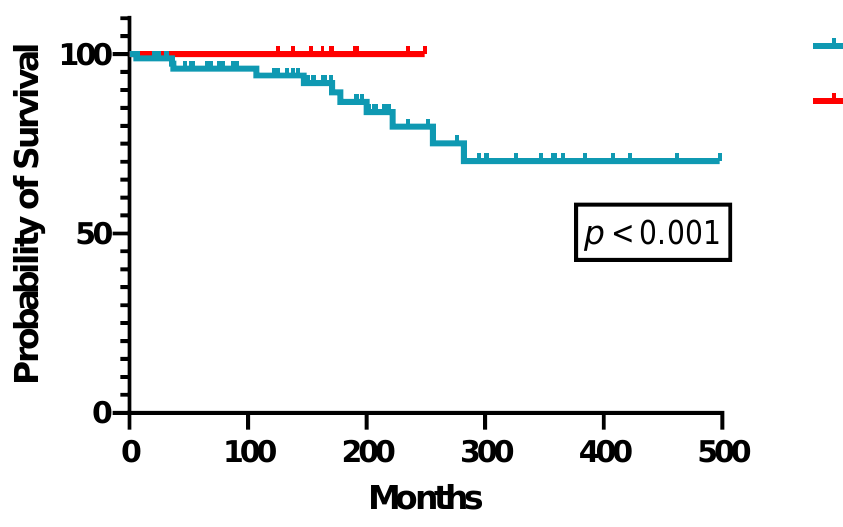
Figure 1. Overall survival according to treatment necessity ( n = 83).